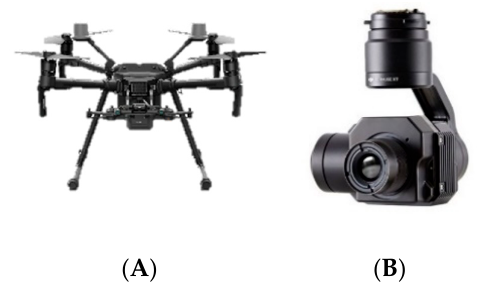
Figure 19. ( A ) DJI M210. ( B ) Zenmuse XT.